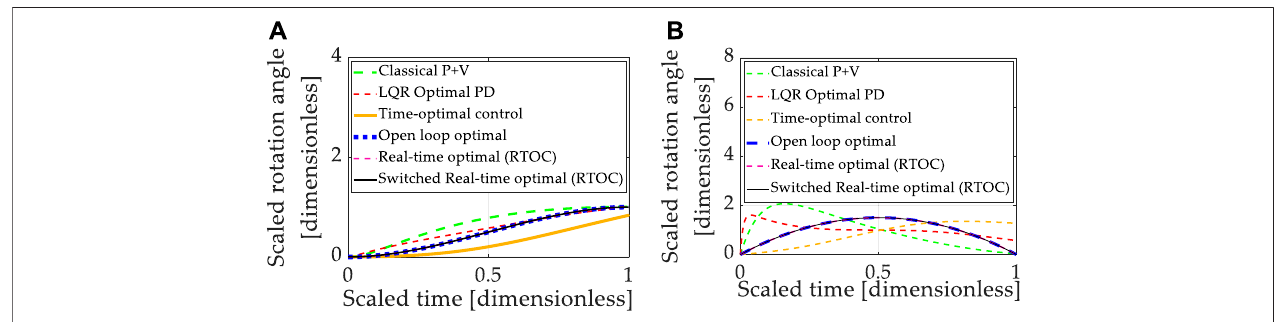
FIGURE 5 | Double-integrator plant (no transport theorem) with control design based on double-integrator. (A) Motion states (translation or rotational) normalized topropagatefromzeroandunityinonenormalizedsecond. (B) Motion rates (translationorrotational)intendedtopropagatefromzeroinitialvelocitytozerovelocityatthe endpoint in one normalized second.